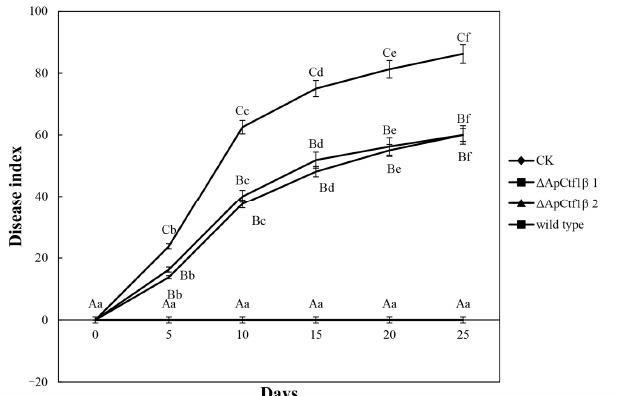
Figure 14. Dynamic changes in the disease index of B. pervariabilis × D. grandis . infected by different strains. Note: CK, Δ Ap Ctf1 β 1 , Δ Ap Ctf1 β 2 and wild type represent the changes in the disease index of B. pervariabilis × D. grandis . inoculated with sterile deionized water, Ctf1 β 1 deletion mutant, Ctf1 β 2 deletion mutant and wild-type A. phaeospermum, respectively. All assays were repeated three times, the data were analyzed using one-way ANOVA and Duncan’s range test in SPSS 16.0. Different capital letters indicate that the disease index of different strains in the same period is significantly different, and different lowercase letters indicate that the disease index of the same strain in different periods is significantly different ( p ≤ 0.01).